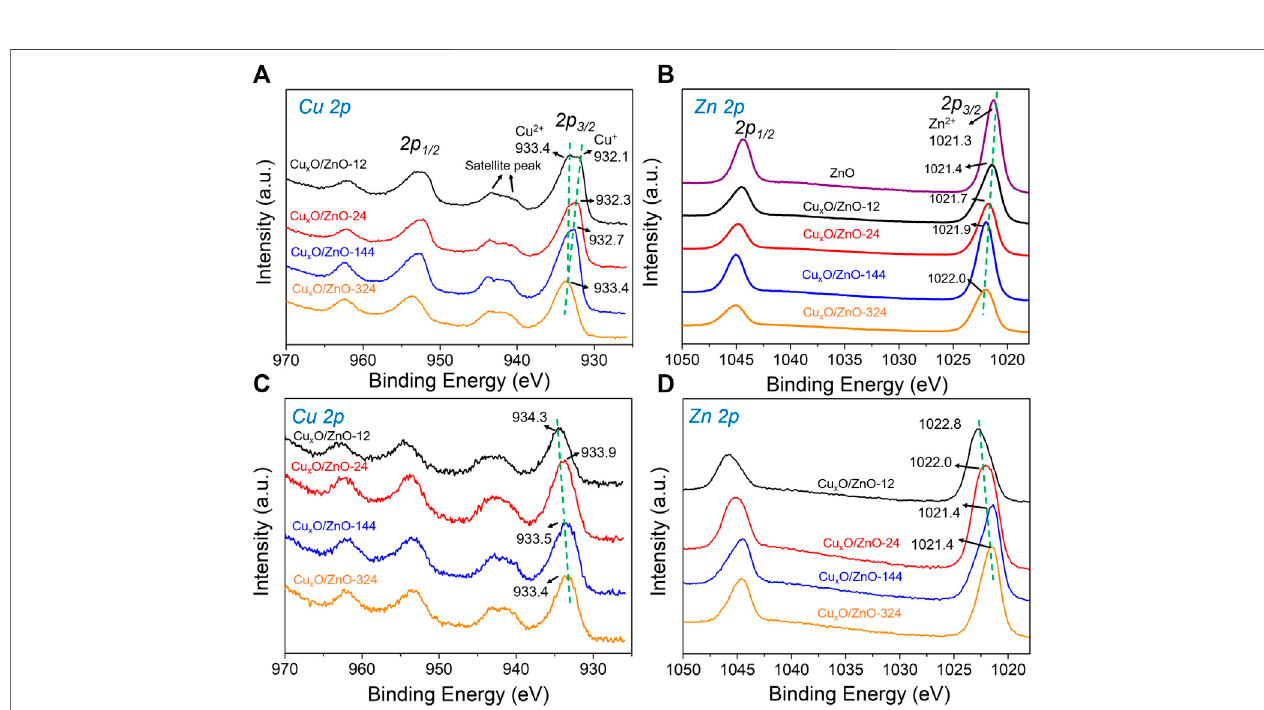
FIGURE 6 | X-ray photoelectron spectra of the catalysts: (A) Cu 2p spectra of the fresh catalyst; (B) Zn 2p spectra of the fresh catalyst; (C) Cu 2p spectra of the used catalyst; (D) Zn 2p spectra of the used catalyst.